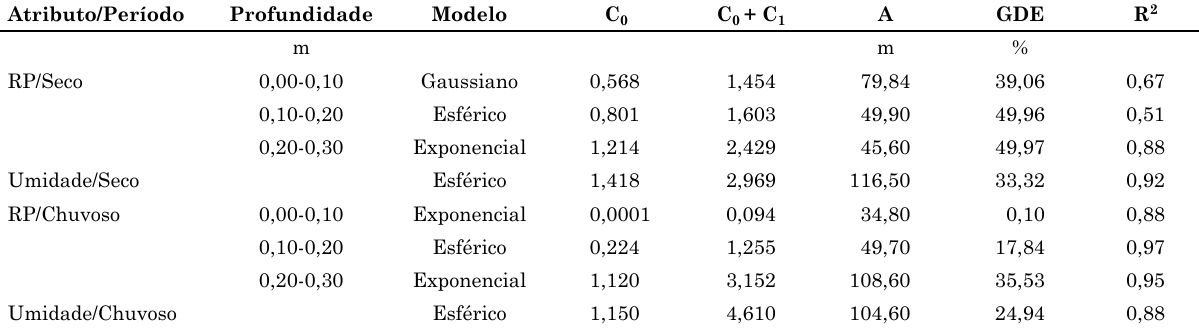
Quadro 2. análise geoestatística para resistência à penetração (rp) e umidade do solo nas profundidades de 0,00-0,10; 0,10-0,20 e 0,20-0,30 m, em período seco e